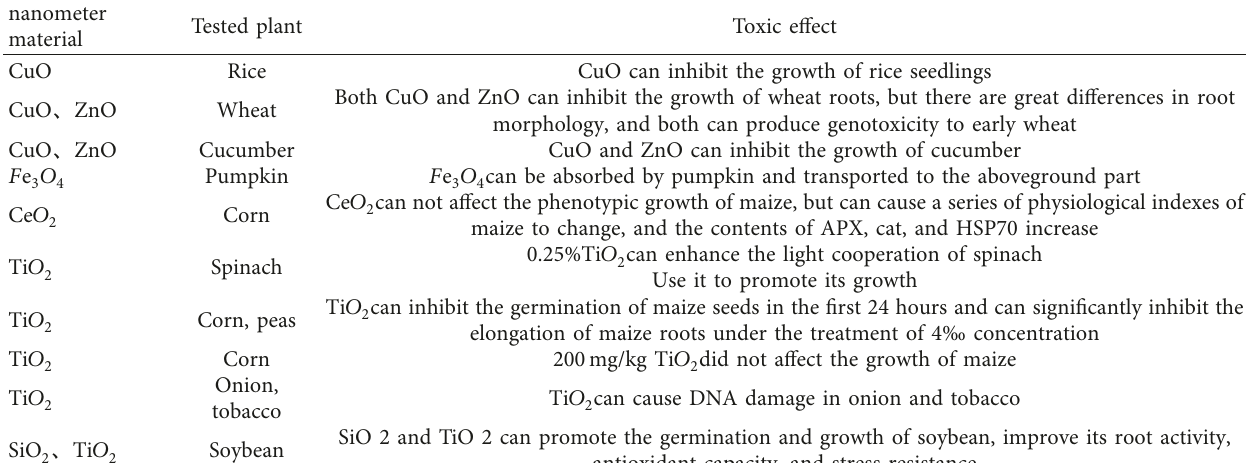
Table 1: Phytotoxic effects of different metal oxide